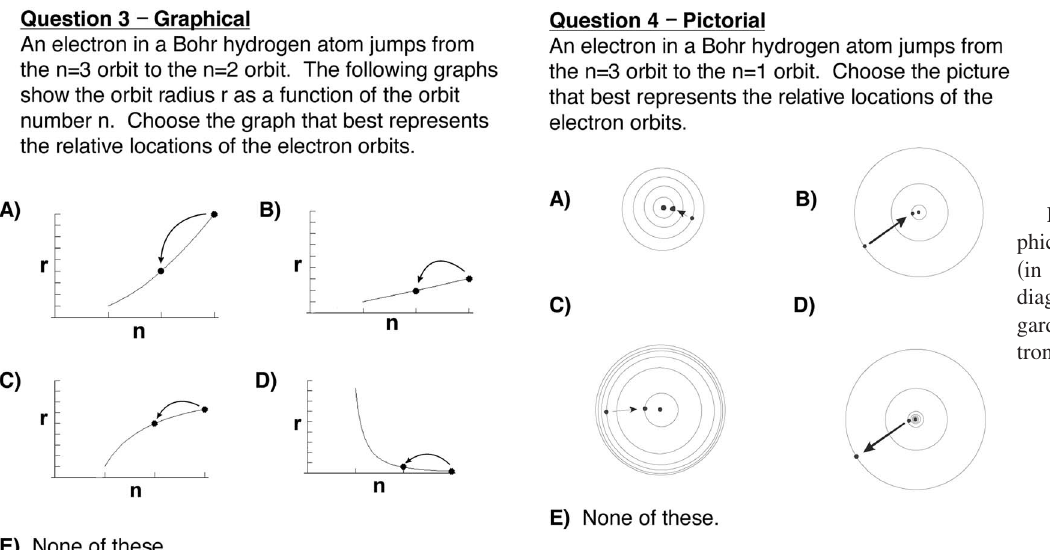
FIG. 1. Nearly isomor- phic homework problems (cid:1) in graphical and pictoral/ diagrammatic formats (cid:2) re- garding Bohr-model elec- tron orbit